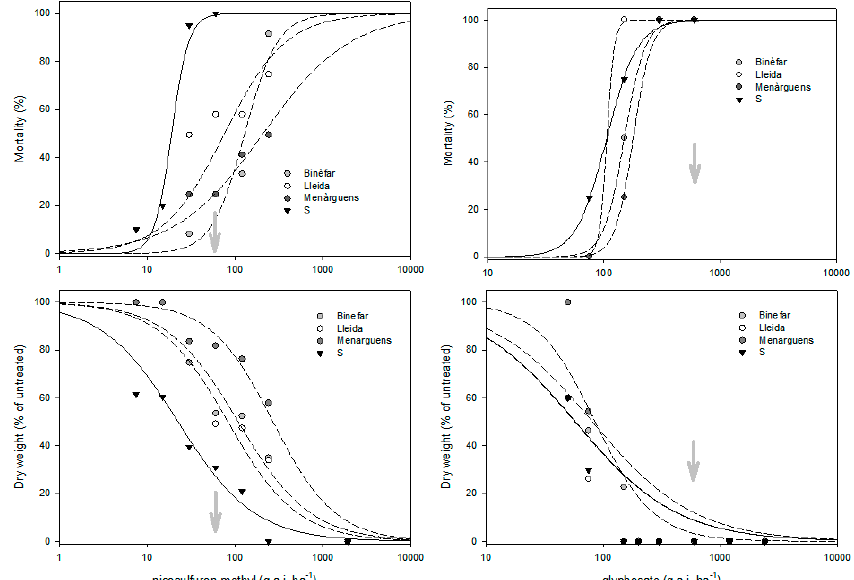
Figure 1. Dose–response regression curves (2018) for mortality (above graphs) and dry weight (below graphs) of S standard (Georgia, US) and Spanish (Binéfar, Menàrguens and Lleida) Amaranthus palmeri populations to nicosulfuron-methyl ( left ) and glyphosate ( right ) (log scale). Data for dry weight were expressed as percentage of the mean dry weight of untreated control plants. Grey arrows represent field dose for each herbicide.